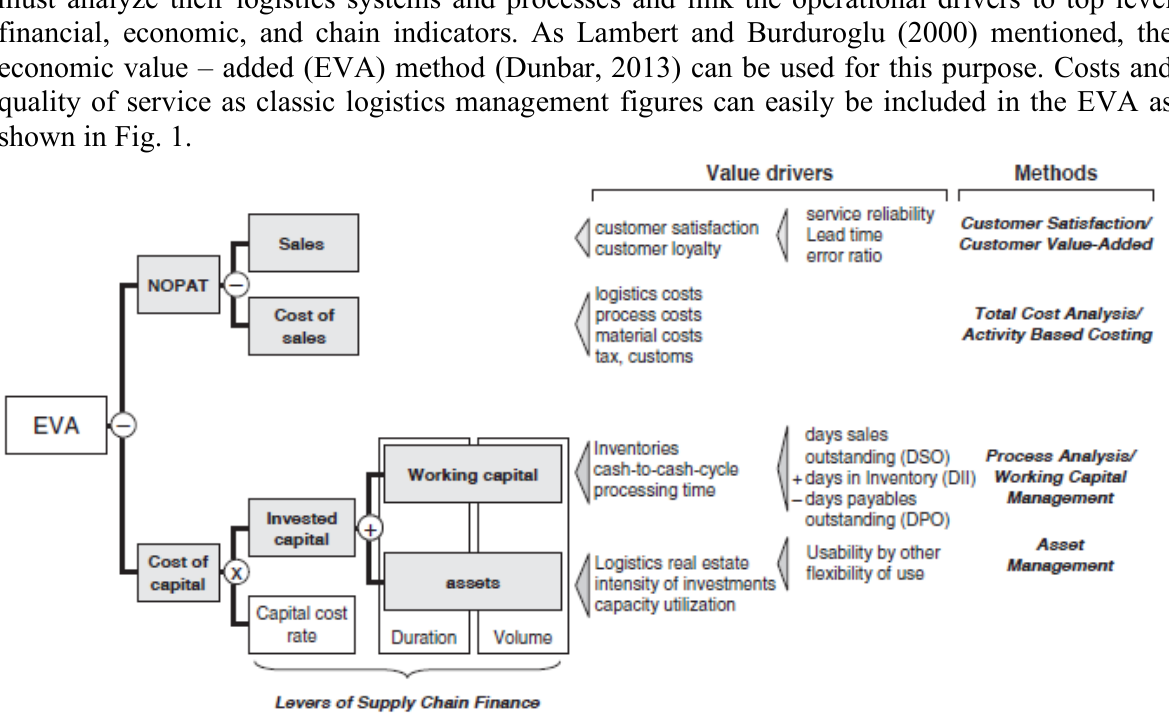
Figure 1 . EVA value-driver hierarchy and levers of SCF (Gomm,